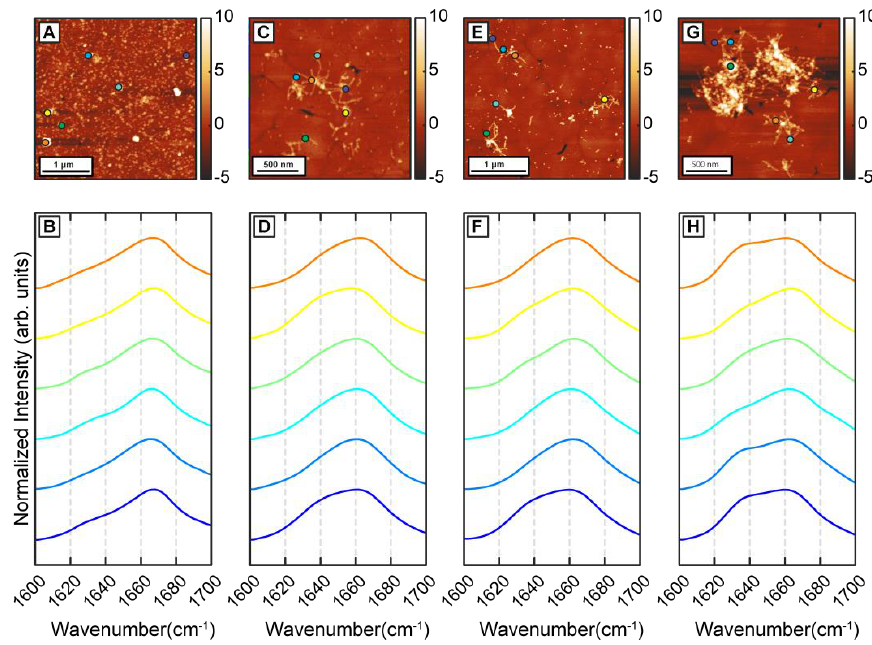
Figure 4. AFM-IR characterization of A β 42 aggregates in presence of β -carotene (1:3 molar ratio). ( A ) AFM topograph of A β 42 oligomer formed after 1 h of incubation. ( B ) Representative IR spectra obtained from oligomers. ( C ) AFM topograph of A β 42 fibrils generated after 6 h and ( D ) representa- tive IR spectra obtained from the sample. ( E ) AFM image of A β 42 fibrils after 24 h and ( G ) 72 h. IR spectra obtained from several points on fibrils from ( F ) 24 h and ( H ) 72 h sample. Dots on the AFM topographs show the corresponding location of IR spectra.